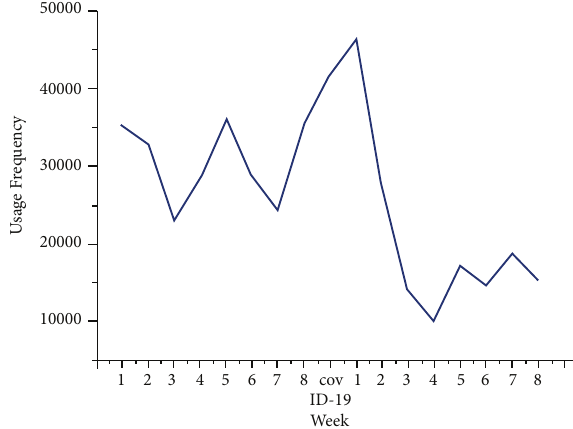
Figure 2: Weekly usage of bike sharing during the period of eight weeks before and after the outbreak of